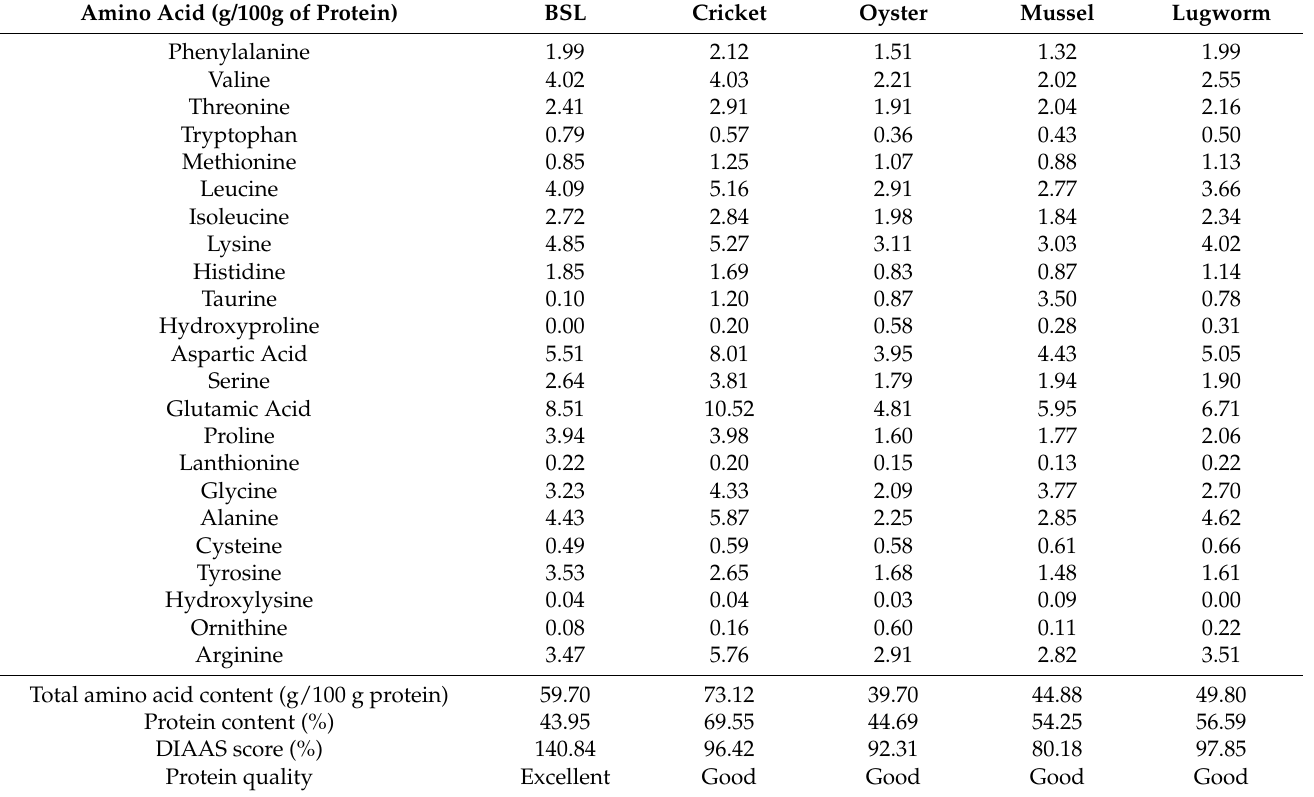
Table 2. Amino acid content, protein content, and quality and degree of hydrolysis of all hydrolysates. Amino Acid (g/100g of